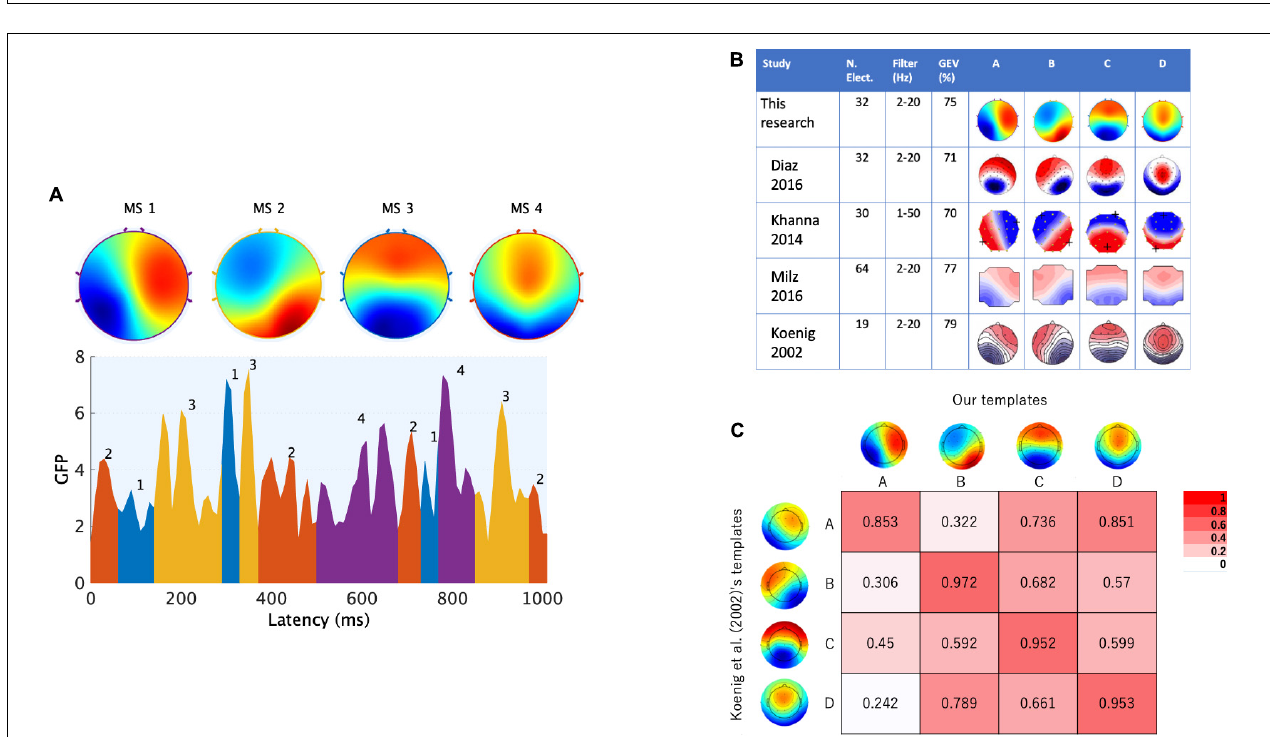
FIGURE 1 | Schematics of EEGms neurofeedback system. The referenced bipolar signals are processed every 100 ms (10 Hz) into an epoch-averaged spatial pattern. This current state is compared with four EEGms templates on the basis of spatial similarity (Pearson’s correlation). When the largest value among the four absolute correlation coefficients is greater than 0.8 (for example) threshold, the display suggests a green circle in the corresponding area. The targeted state is suggested at the same time using a blue frame. If the green circle overlaps the blue frame, the participants receive a ringing sound as a reward.